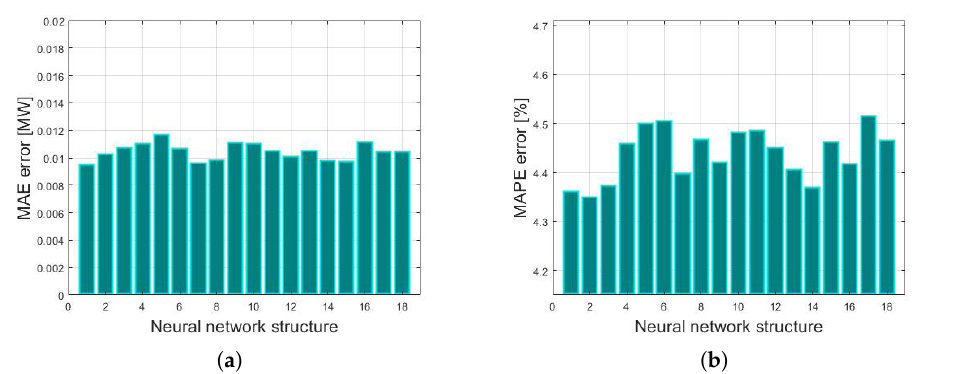
Figure 27. Summary of forecast accuracies by the selected neural network structure for wind power plant FW4. ( a ) MAE. ( b ) MAPE.